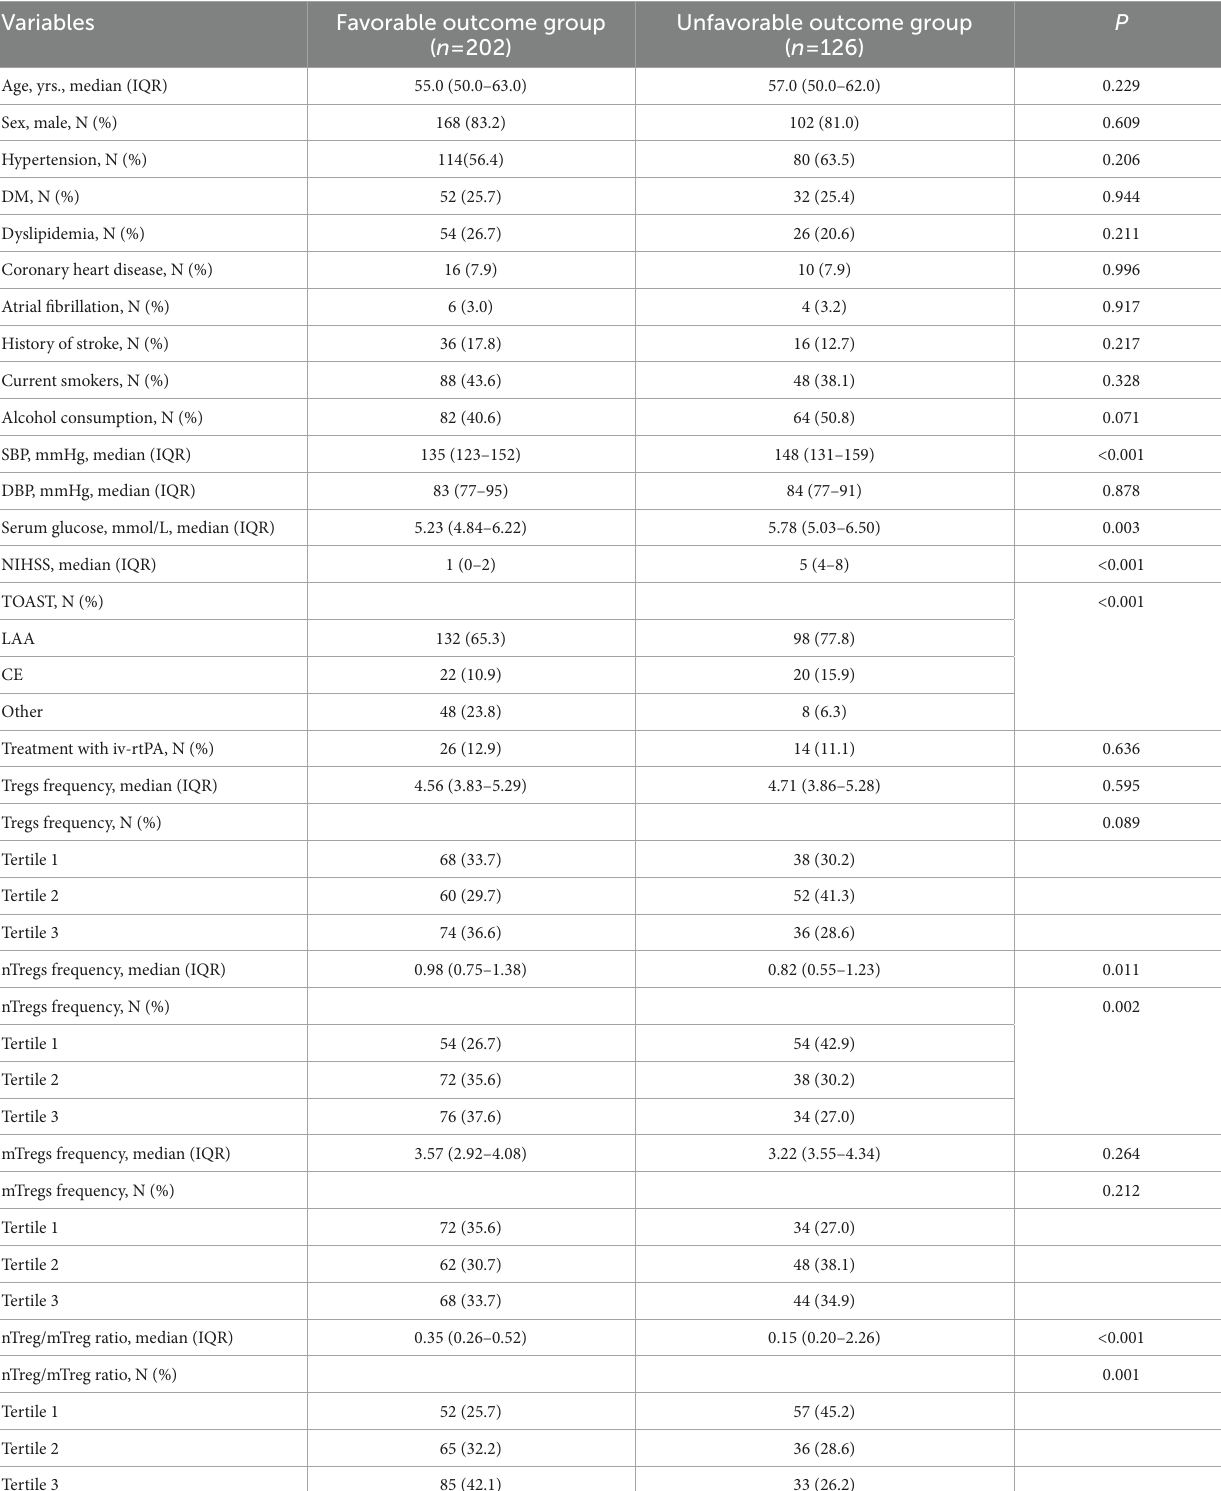
TABLE 2 Baseline characteristics of patients with acute ischemic stroke according to 90-day neurological outcome (modified Rankin Scale 0–1 versus 2–6).